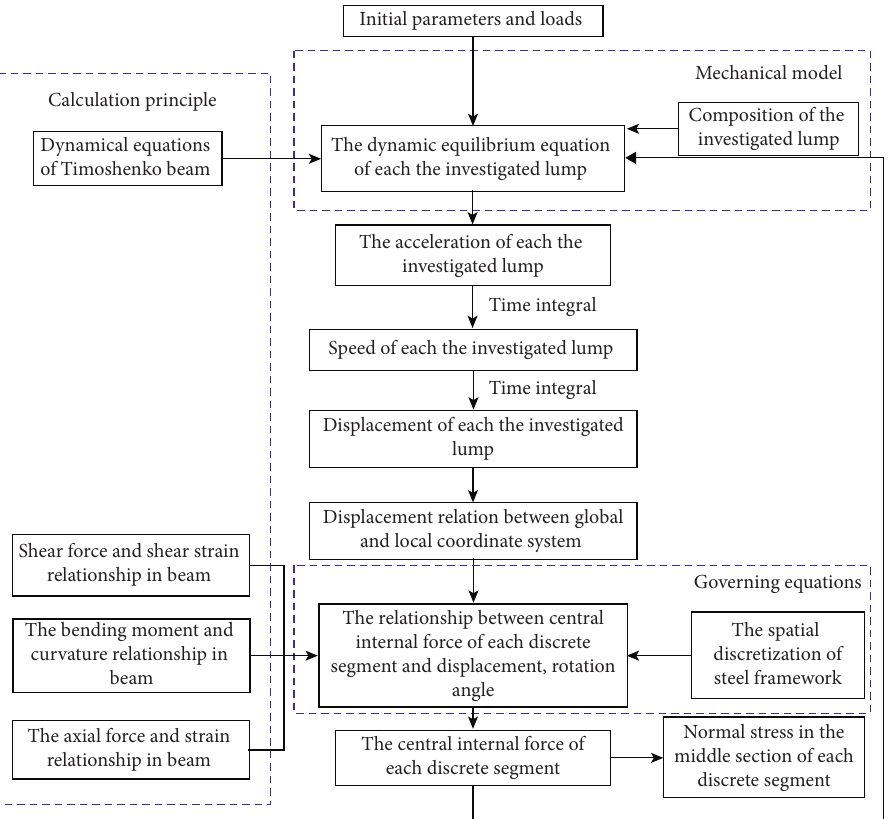
Figure 1: Method structure of dynamic response analysis for greenhouse.